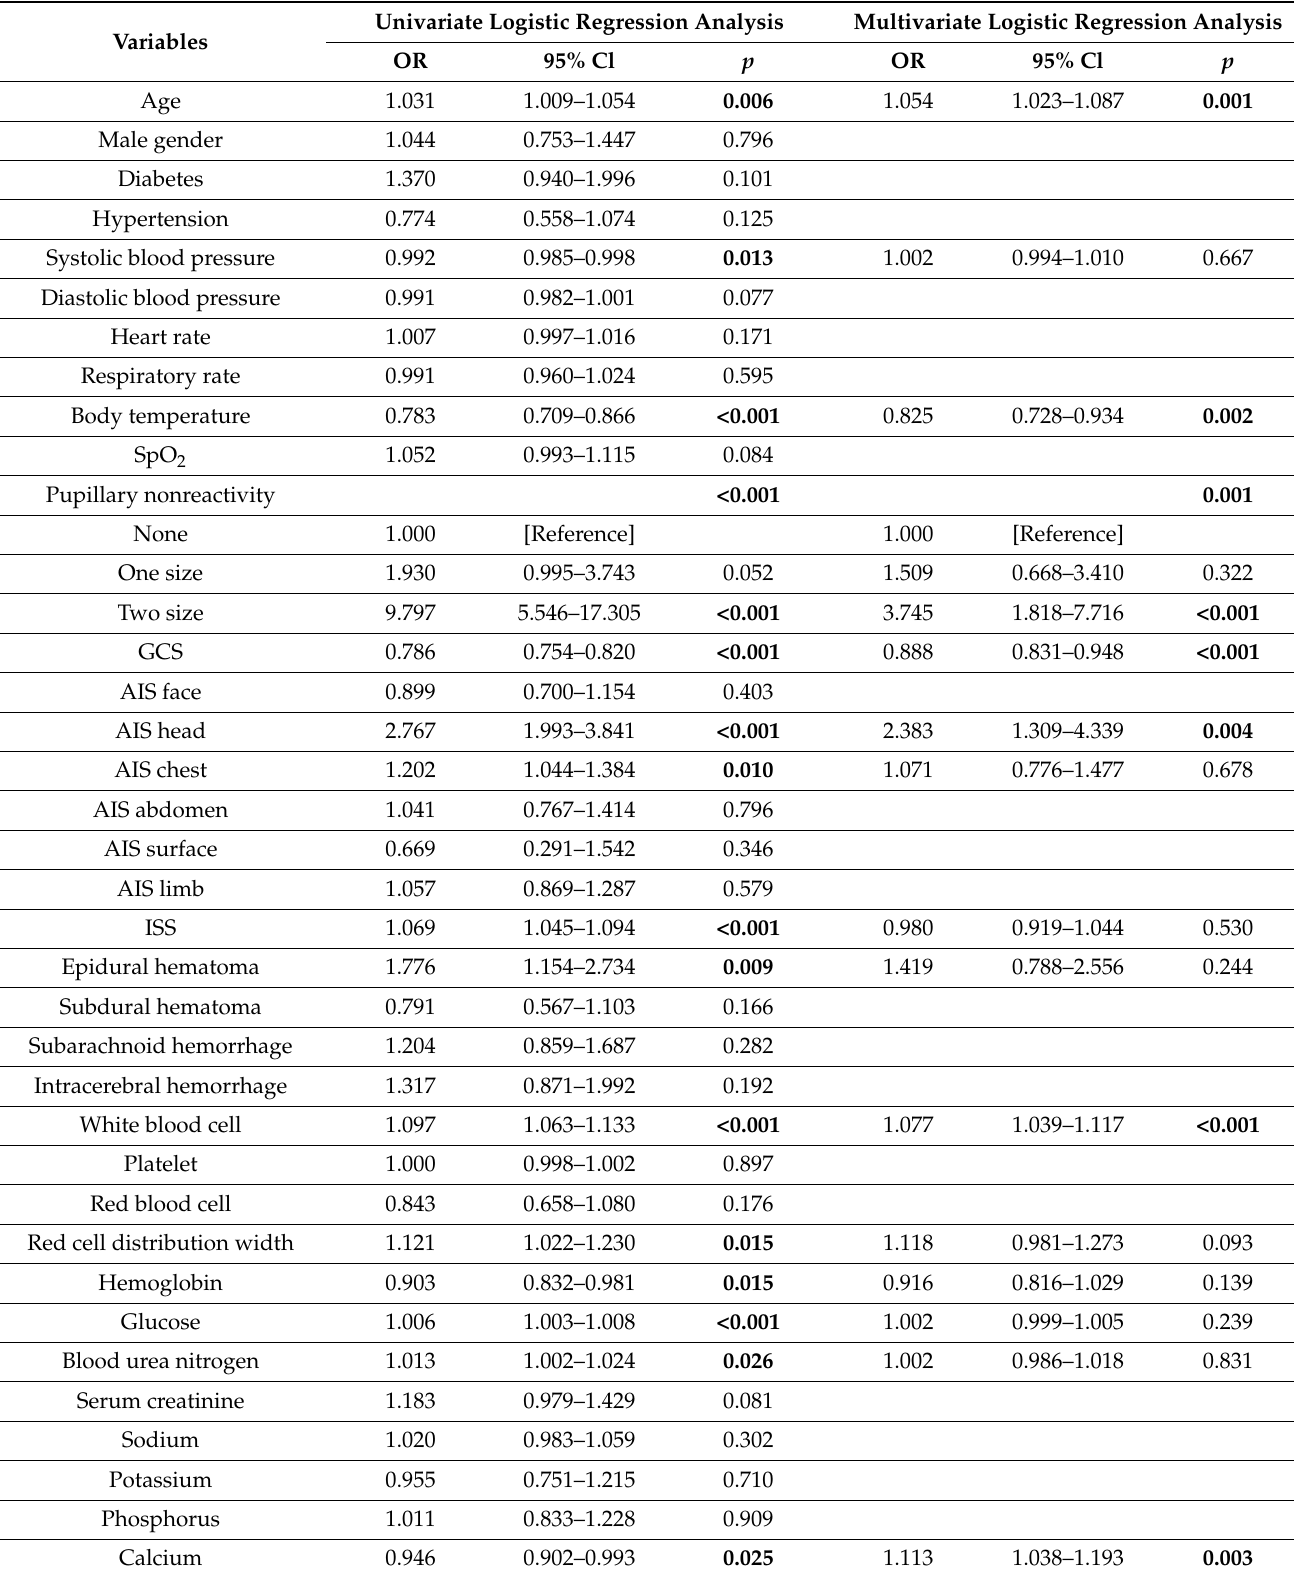
Table 3. Univariate and multivariate logistic regression analysis of risk factors for 30-day mortality in training